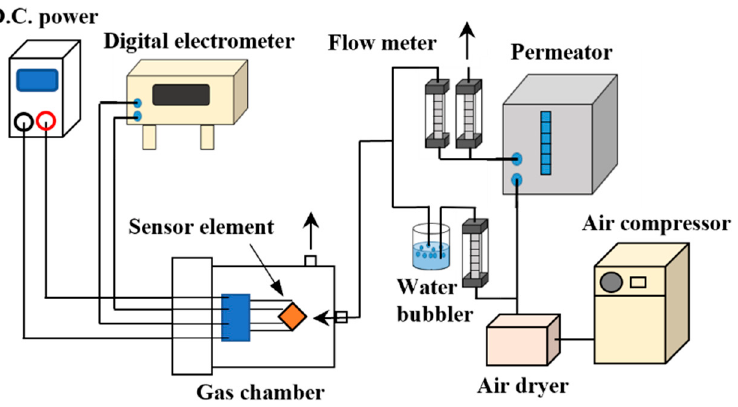
Figure 1. Experimental setup for the sensor test.